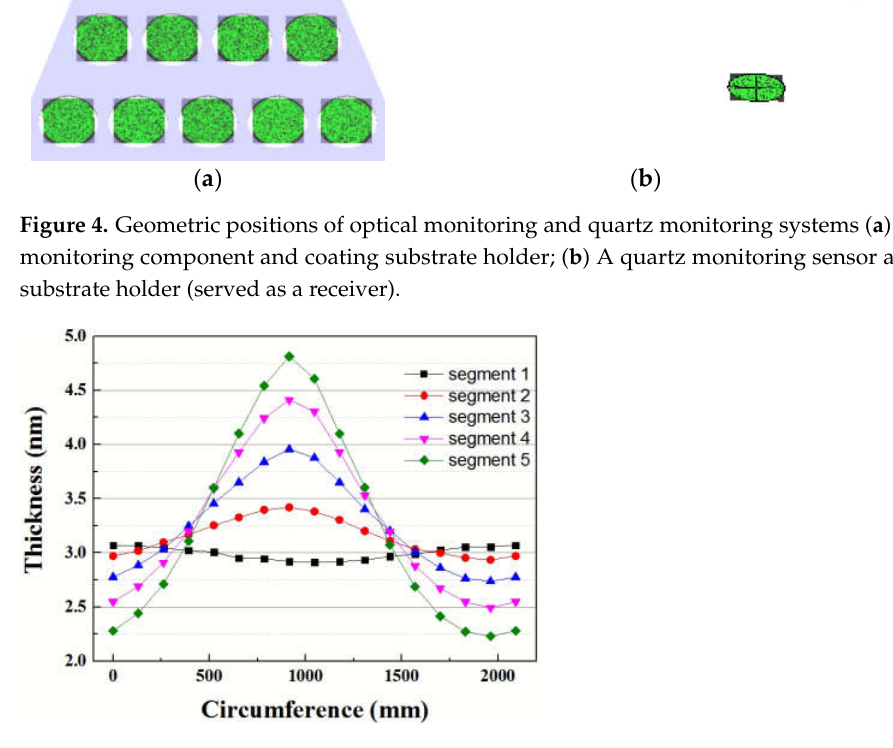
Figure 4. Geometric positions of optical monitoring and quartz monitoring systems ( a ) An optical monitoring component and coating substrate holder; ( b ) A quartz monitoring sensor and coating substrate holder (served as a receiver).